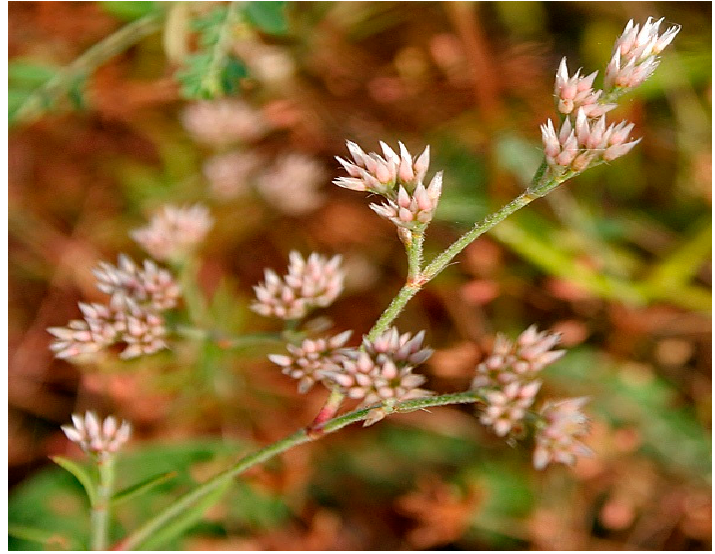
Figure 12. Image of Polycarpea corybosa plant. Source: [129].